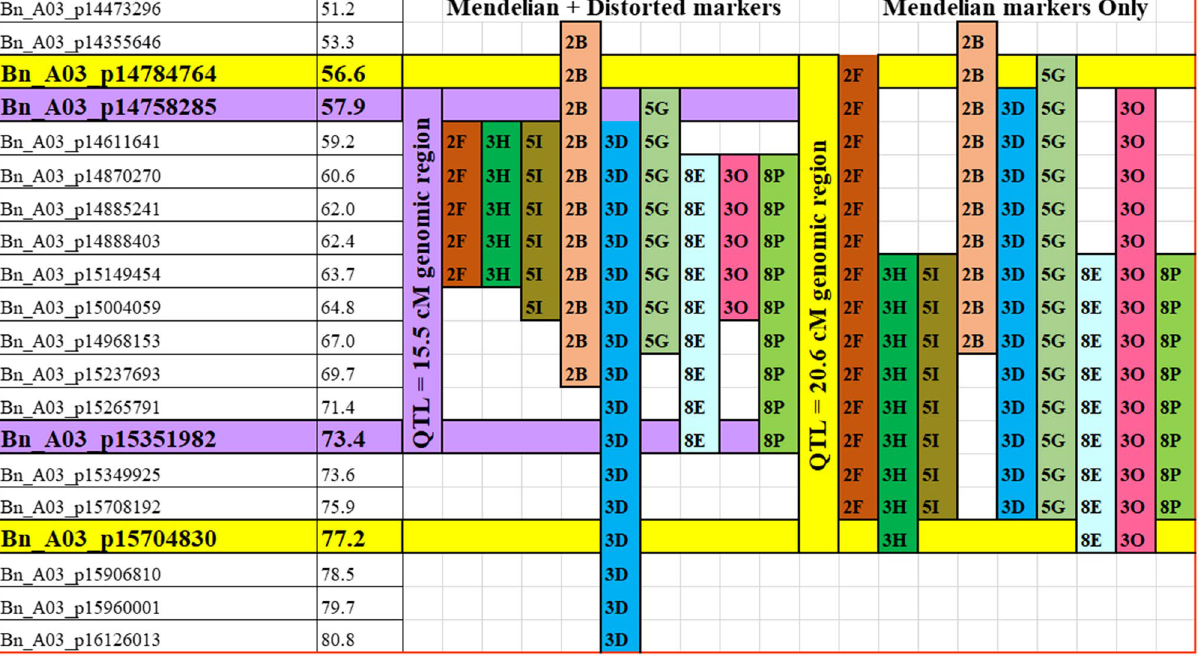
Figure 3. Single-nucleotide polymorphism (SNP) markers and different-sized genomic fragments on the 24.3–26.1 Mb region of the Brassica napus genome (ca. 14.7–15.7 Mb on the Brassica rapa genome), conferring resistance to Plasmodiophora brassicae pathotypes 2F, 3H, 5I, 2B, 3D, 5G, 8E, 3O and